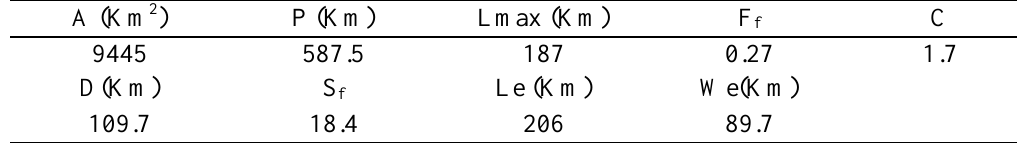
Table 1. Physiographic characteristics of Iranshahr